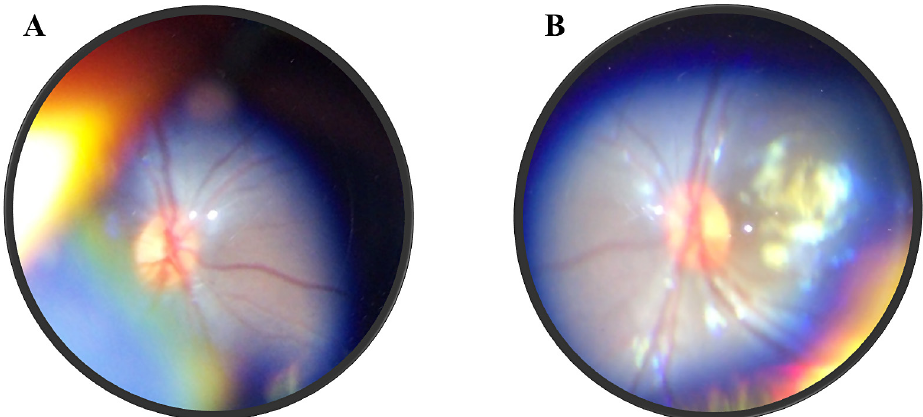
Figure 4: Color photographs of the optic nerve at 1-year follow-up. Note the normal appearance of the optic disc and neuroretinal